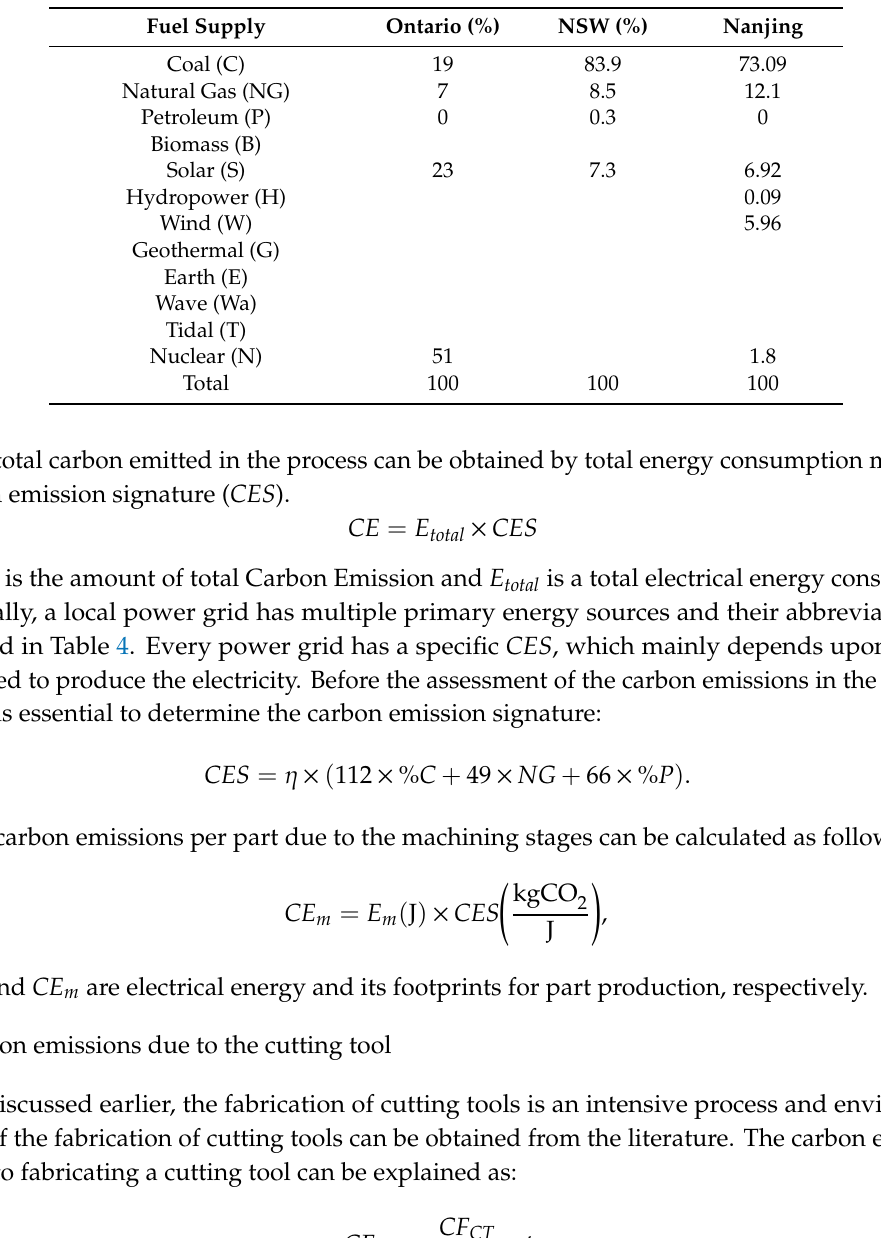
Table 4. Three power grids of di ff erent countries and their input fuel